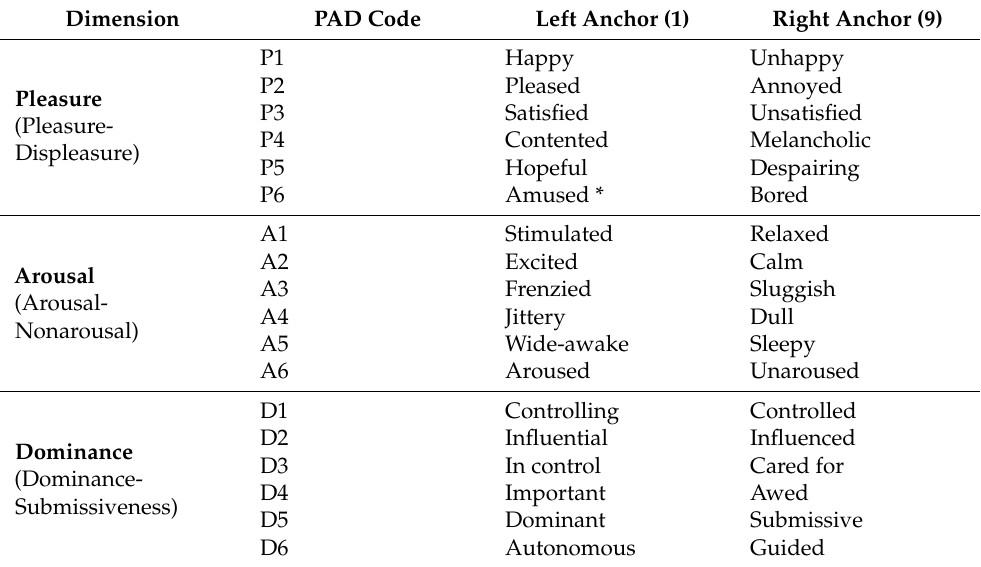
Table 1. The 18 semantic differentials in the pleasure-arousal-dominance (PAD) scale used in Study 1 and Study 2, with end-point anchors shown.